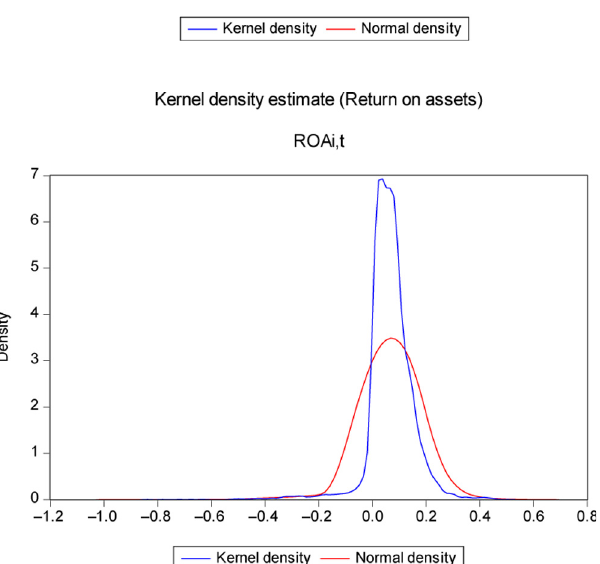
Figure 9. Non-normality of